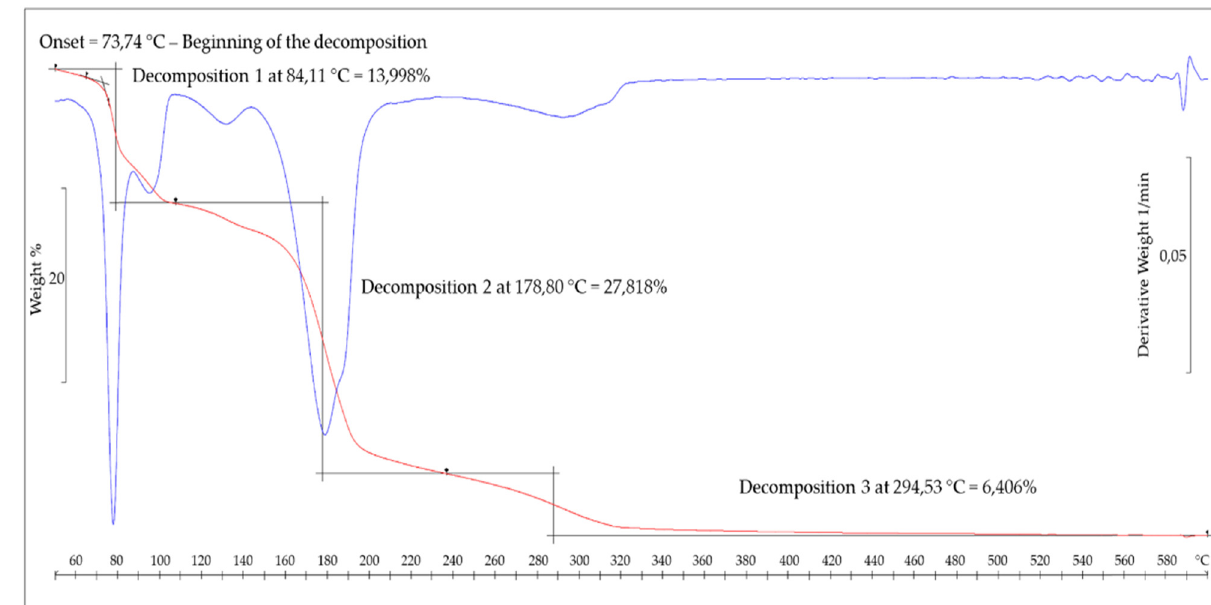
Figure 2: TGA - DT curve for gold chloride ( HAuCl 4 × 3 H 2 O ) , 10°C/min, in